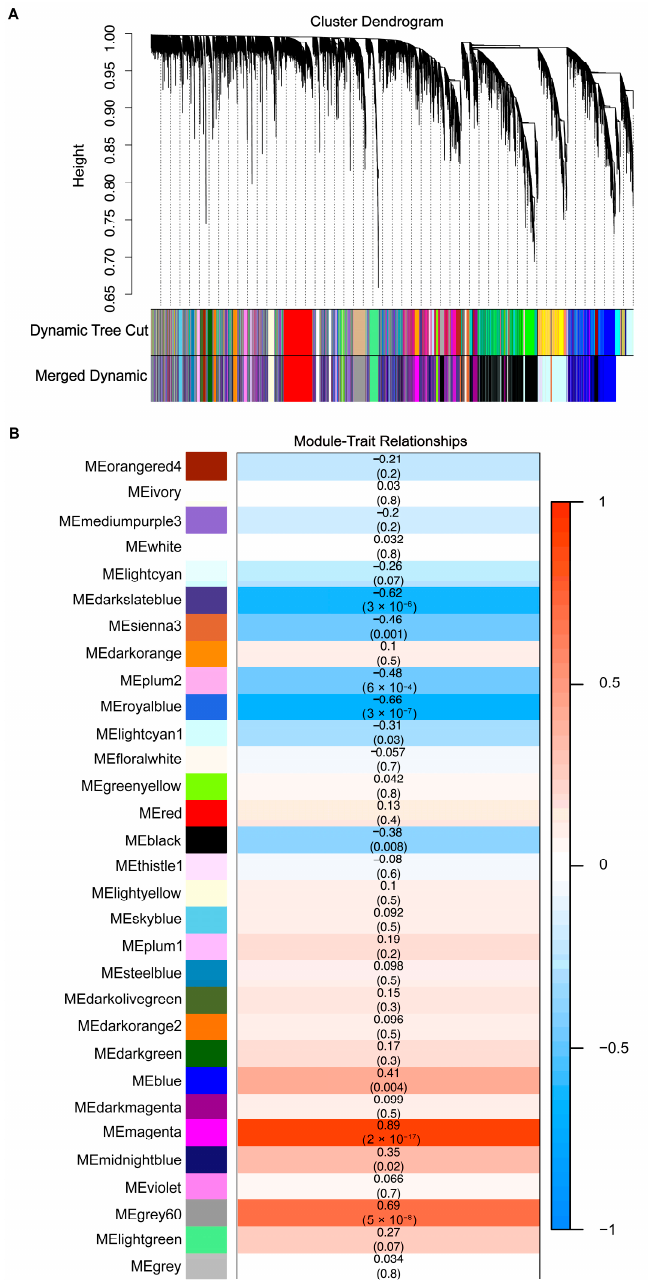
Figure 1. Construction of co-expression network and identification of hub modules. ( A ) Cluster dendrogram. Each branch indicates one gene, and each color represents one co-expression module. ( B ) Heatmap–module–trait relationships. The number in each module indicates the correlation coefficient and the corresponding p